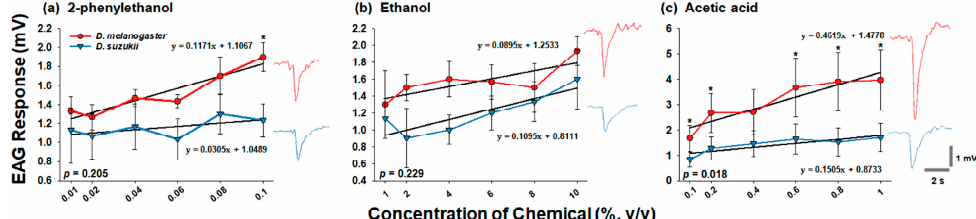
Figure 2. Comparison of EAG responses between Drosophila melanogaster and Drosophila suzukii to ( a ) 2-phenylethanol, ( b ) ethanol, and ( c ) acetic acid. The EAG response values of the two fl ies were statistically analyzed using GLM-repeated measures ANOVA. At the given concentration of the chemicals, Student’s t -test was used to compare EAG values between the two fl y species. Asterisks indicate signi fi cant di ff erences ( p < 0.05). The data are presented as the mean ± standard error. Waveforms of EAG responses of D. melanogaster (red) and D. suzukii (blue) to ( a ) 0.1% 2- phenylethanol, ( b ) 10% ethanol, and ( c ) 1% acetic acid ( c ). Note that the recovery time of EAG was longer in acetic acid stimulations than that in other stimulations. EAG, electroantennogram.